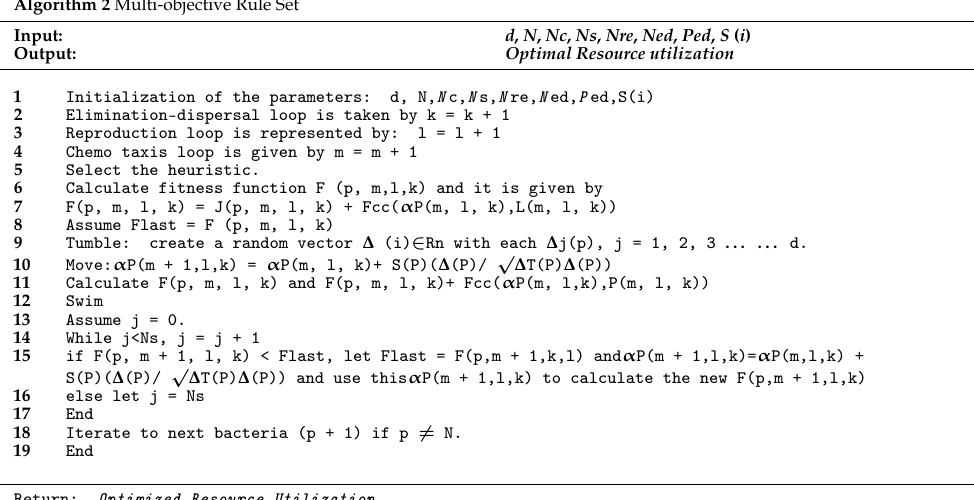
Algorithm 2 Multi-objective Rule